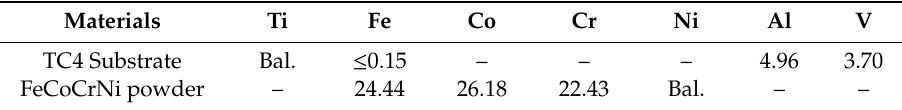
Table 1. Chemical compositions of the substrate and FeCoCrNi powder (wt%).